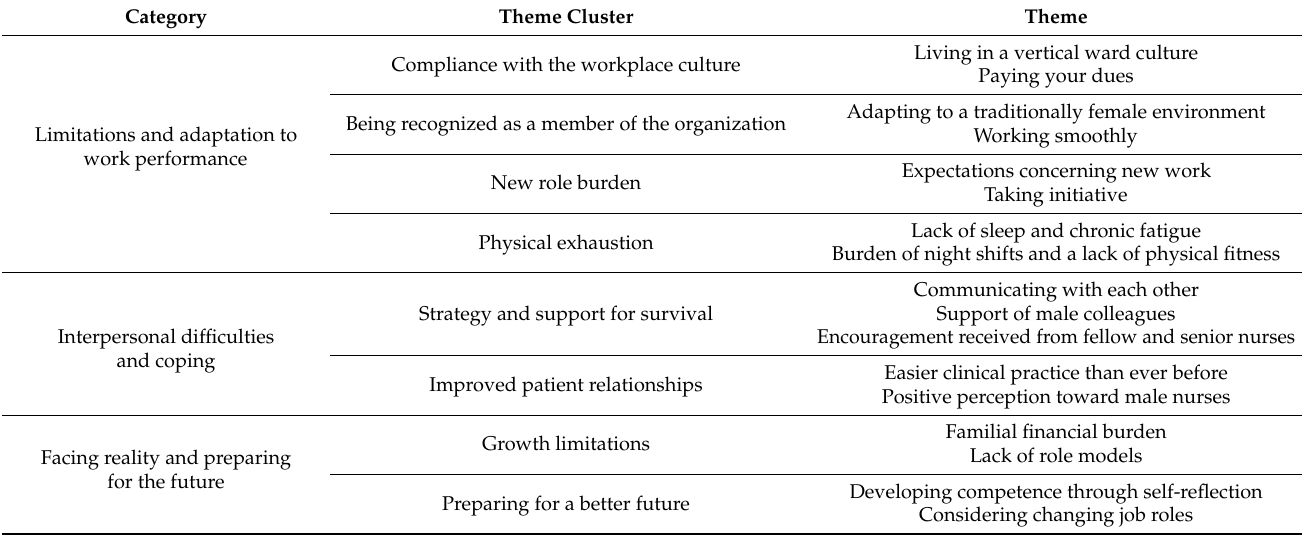
Table 2. Clinical work and life of mid-career male